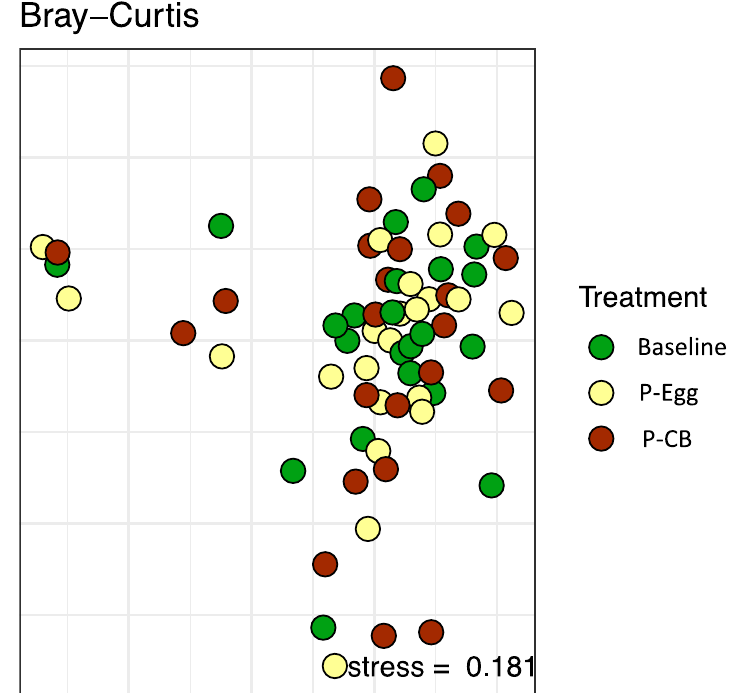
Figure 4. Nonmetric multidimensional scaling of the Bray–Curtis dissimilarity index, showing the relationship between individual samples based on the species and their abundances at baseline, post 3 eggs/d, and post-CB supplementation for 4